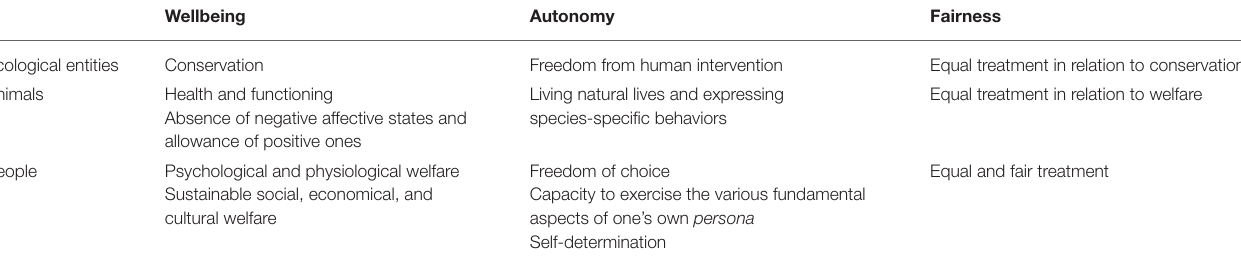
TABLE 2 | General EM. Wellbeing Ecological entities Animals Living natural lives and expressing